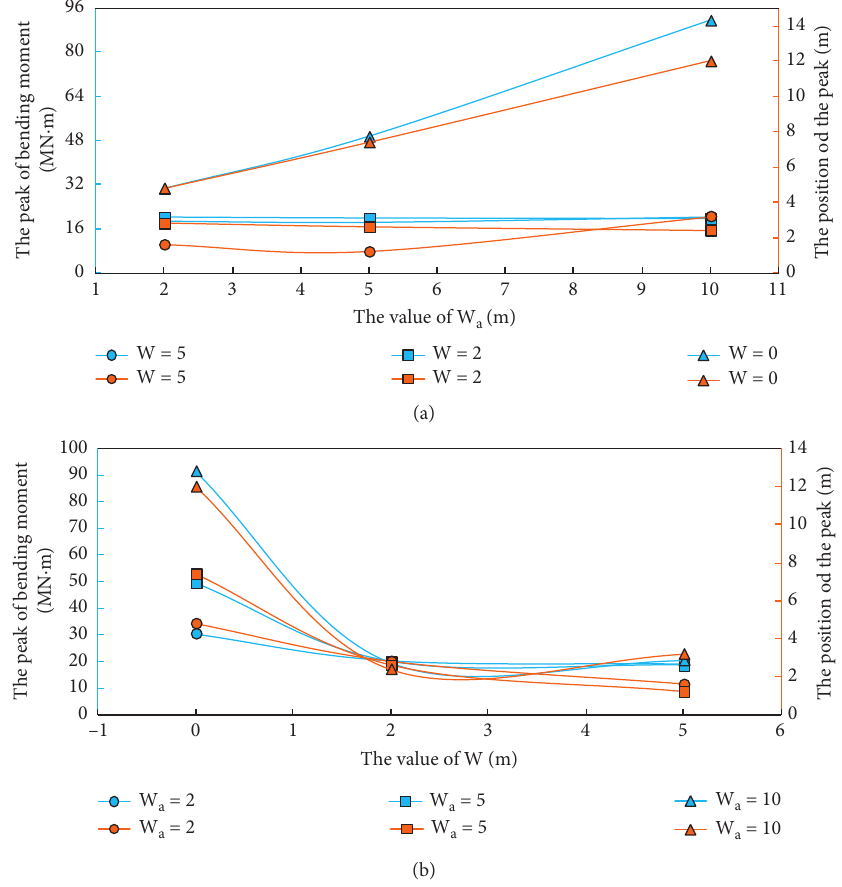
Figure 10: Sensibility factors analysis of the peak of bending moment. (a) Different values of W